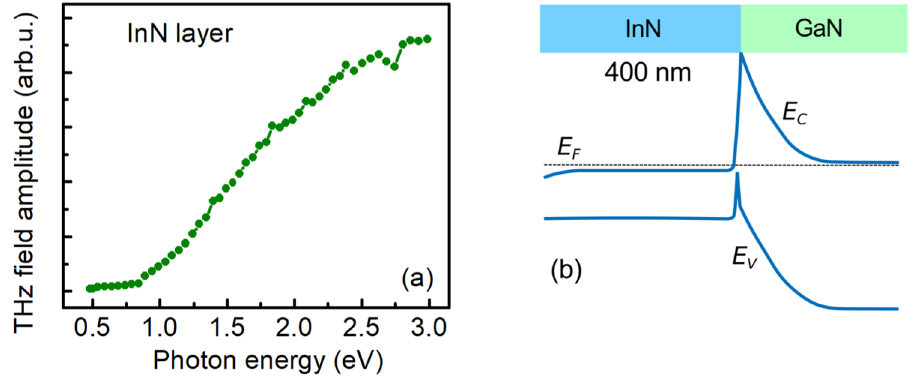
Figure 2. ( a ) The amplitude of THz field as a function of excitation photon energy in InN layer. ( b ) The modelled energy bands in the InN